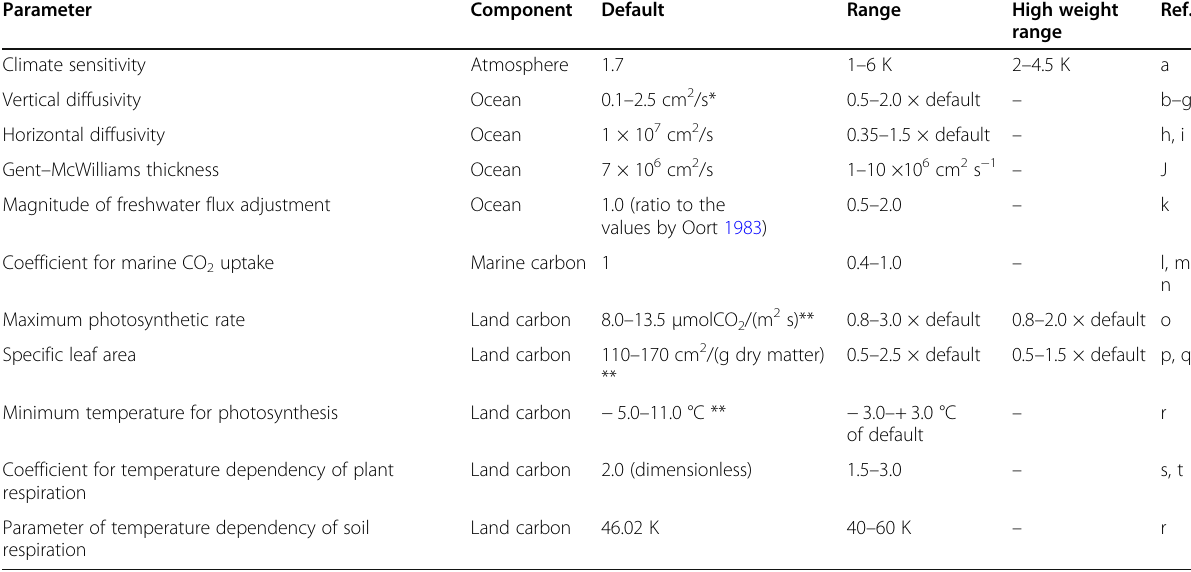
Table 1 Nature and ranges of the parameters perturbed in the present study